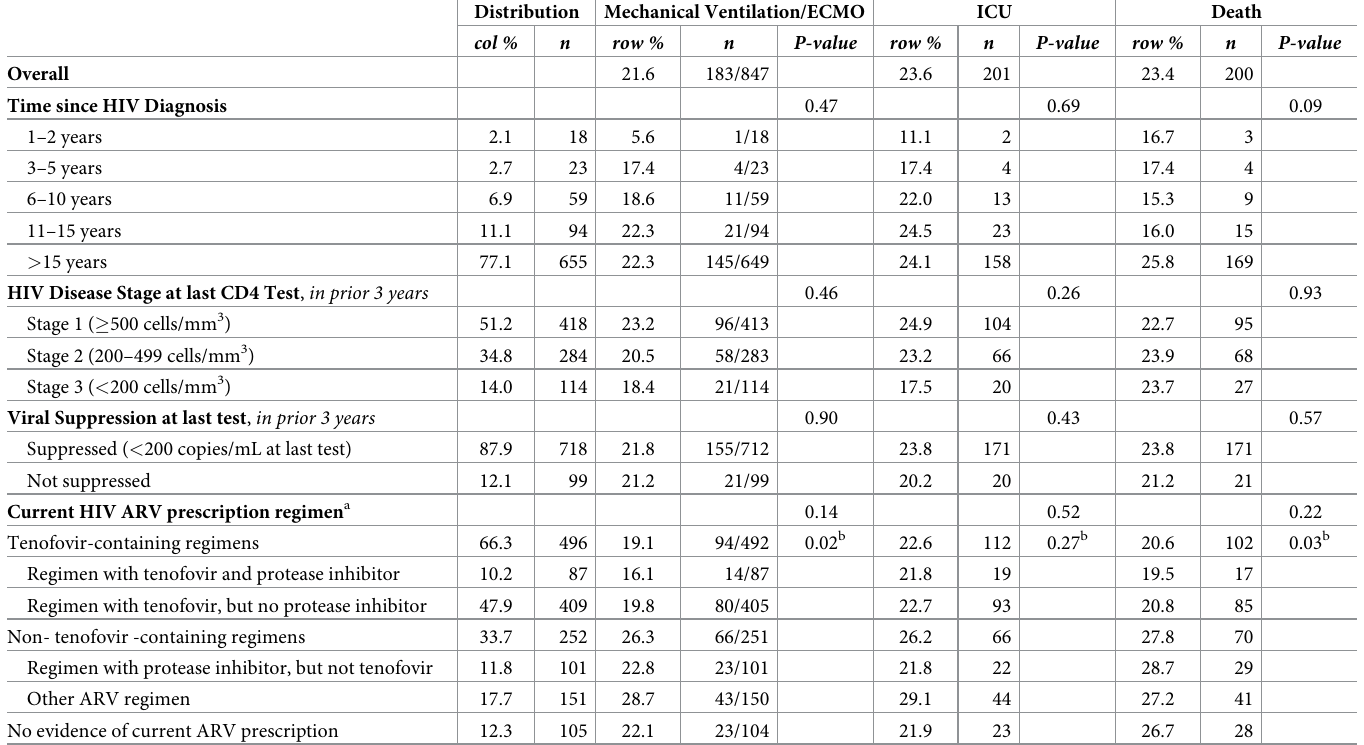
Table 5. Distribution of and hospital outcomes associated with HIV-related characteristics among PLWDH hospitalized with COVID-19. Distribution Mechanical